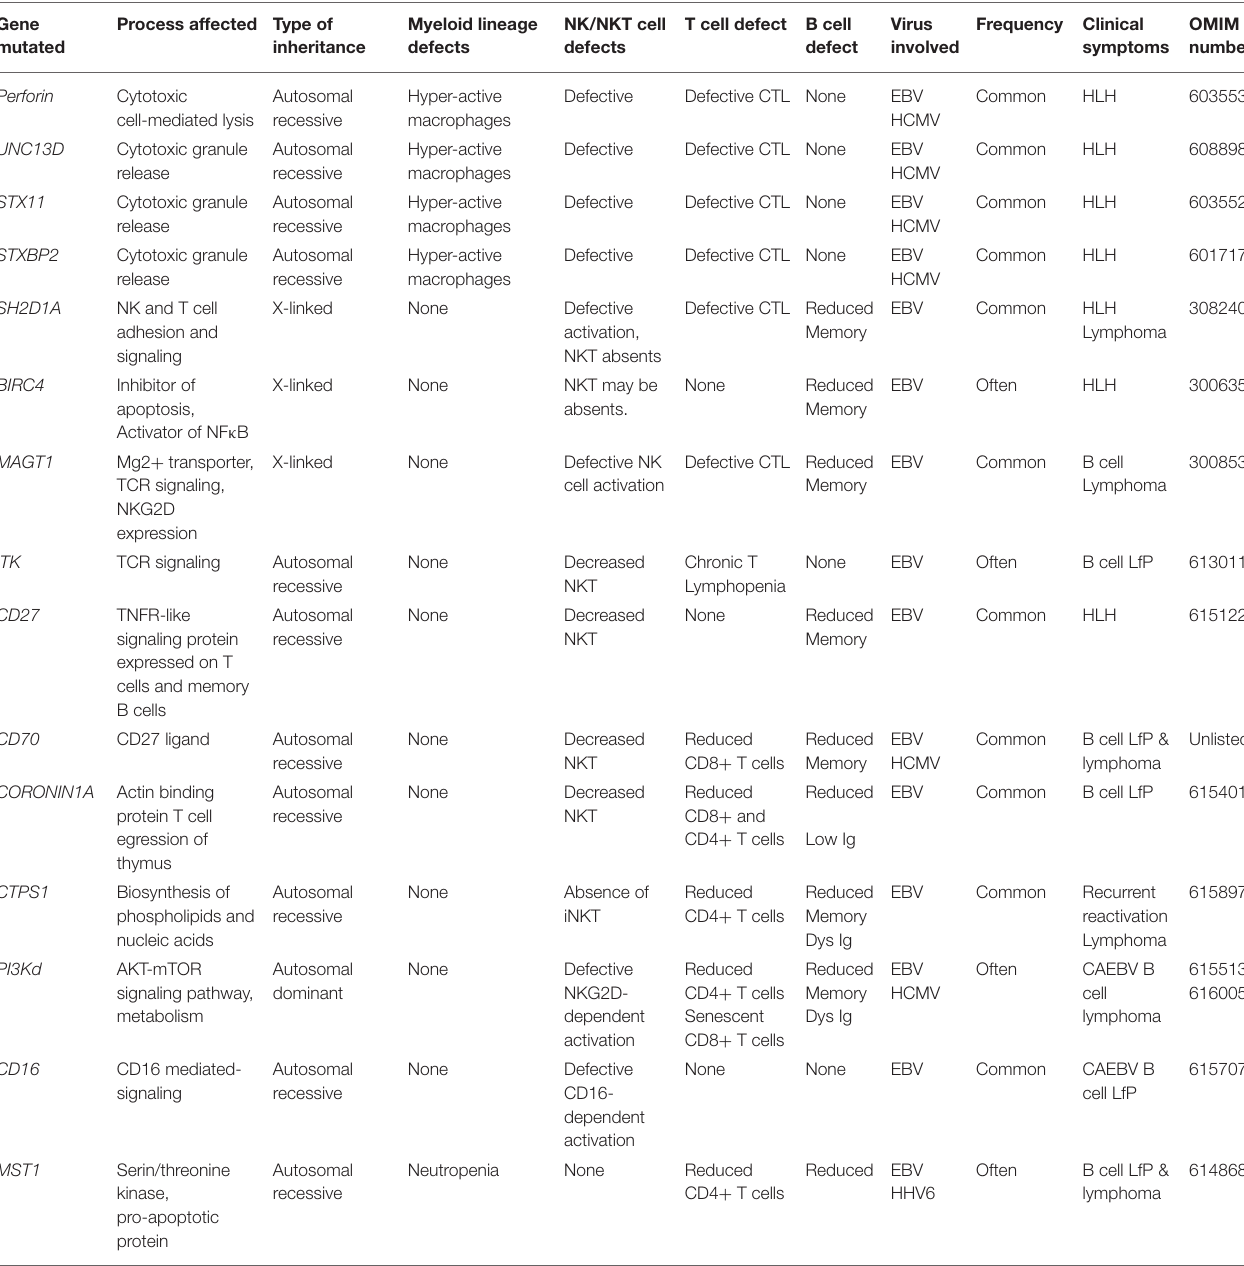
TABLE 1 | Inborn errors and genetic syndromes characterized by an increased susceptibility to EBV -associated morbidity. Gene